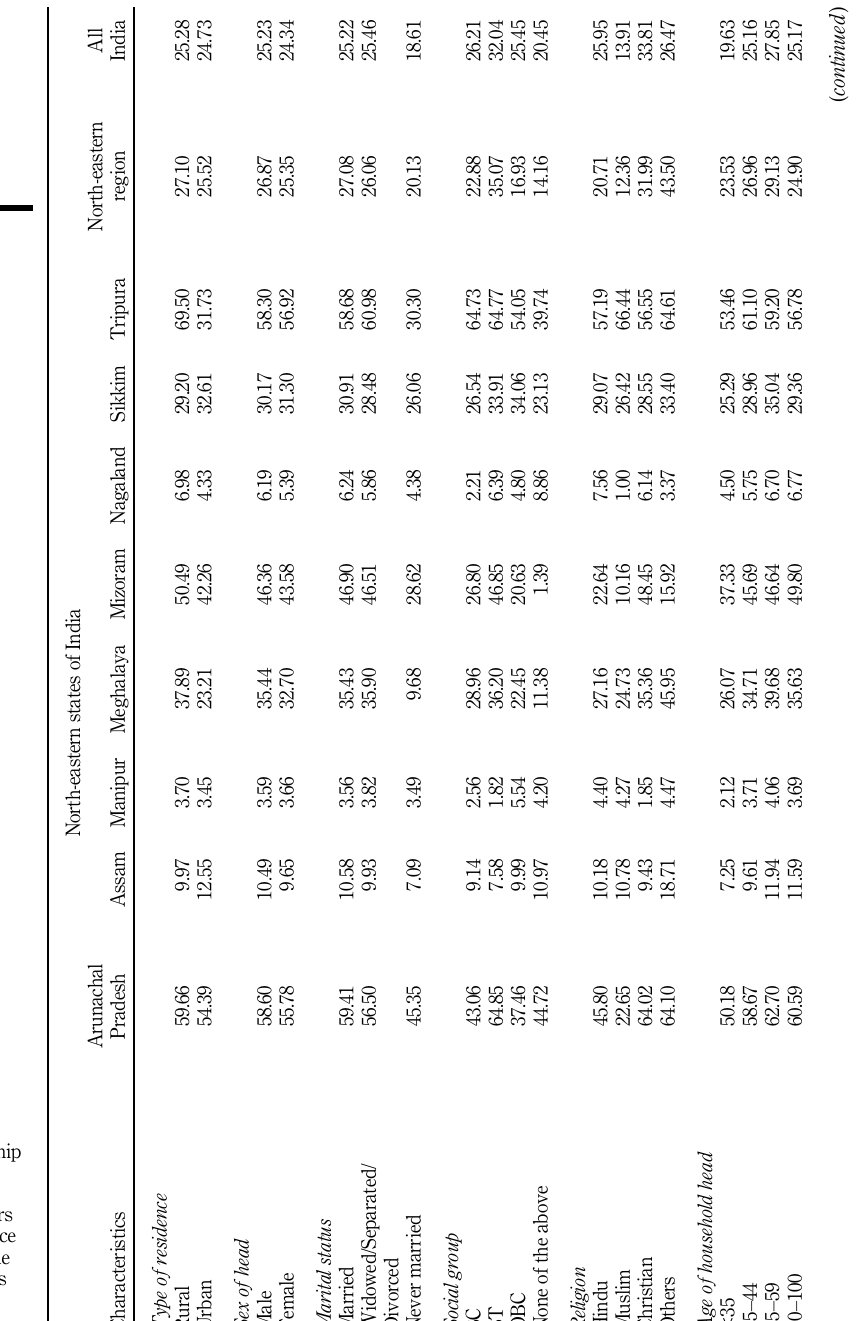
Table 2. Bivariate relationship between the socioeconomic demographic factors and health insurance coverage among the north-eastern states of